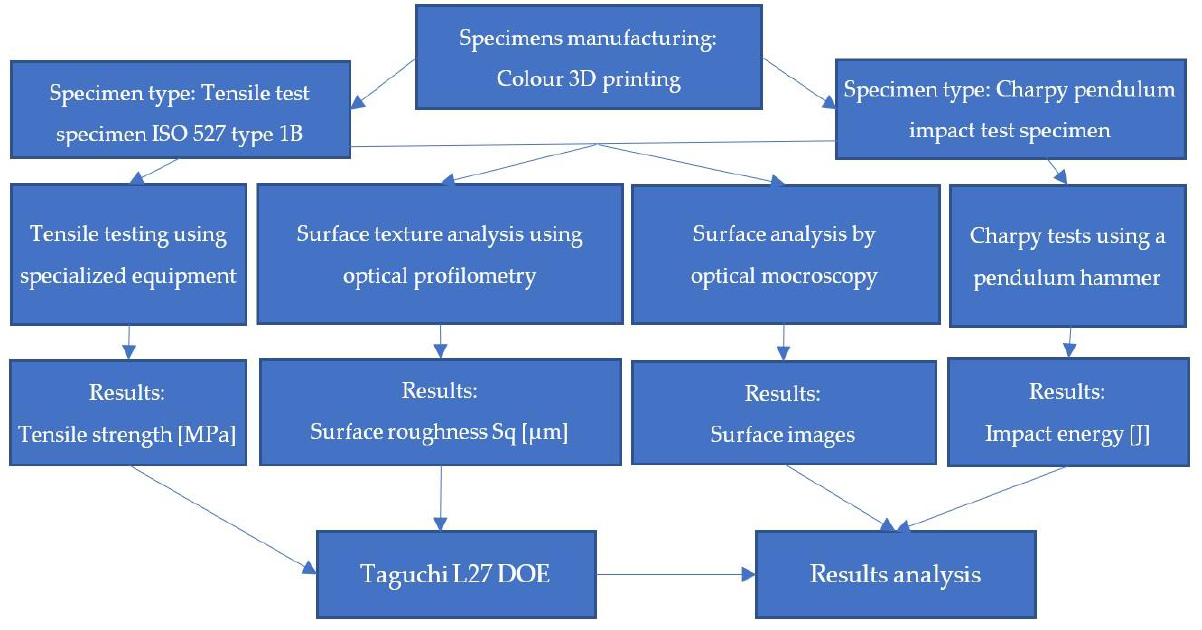
Figure 3. Experimental program.